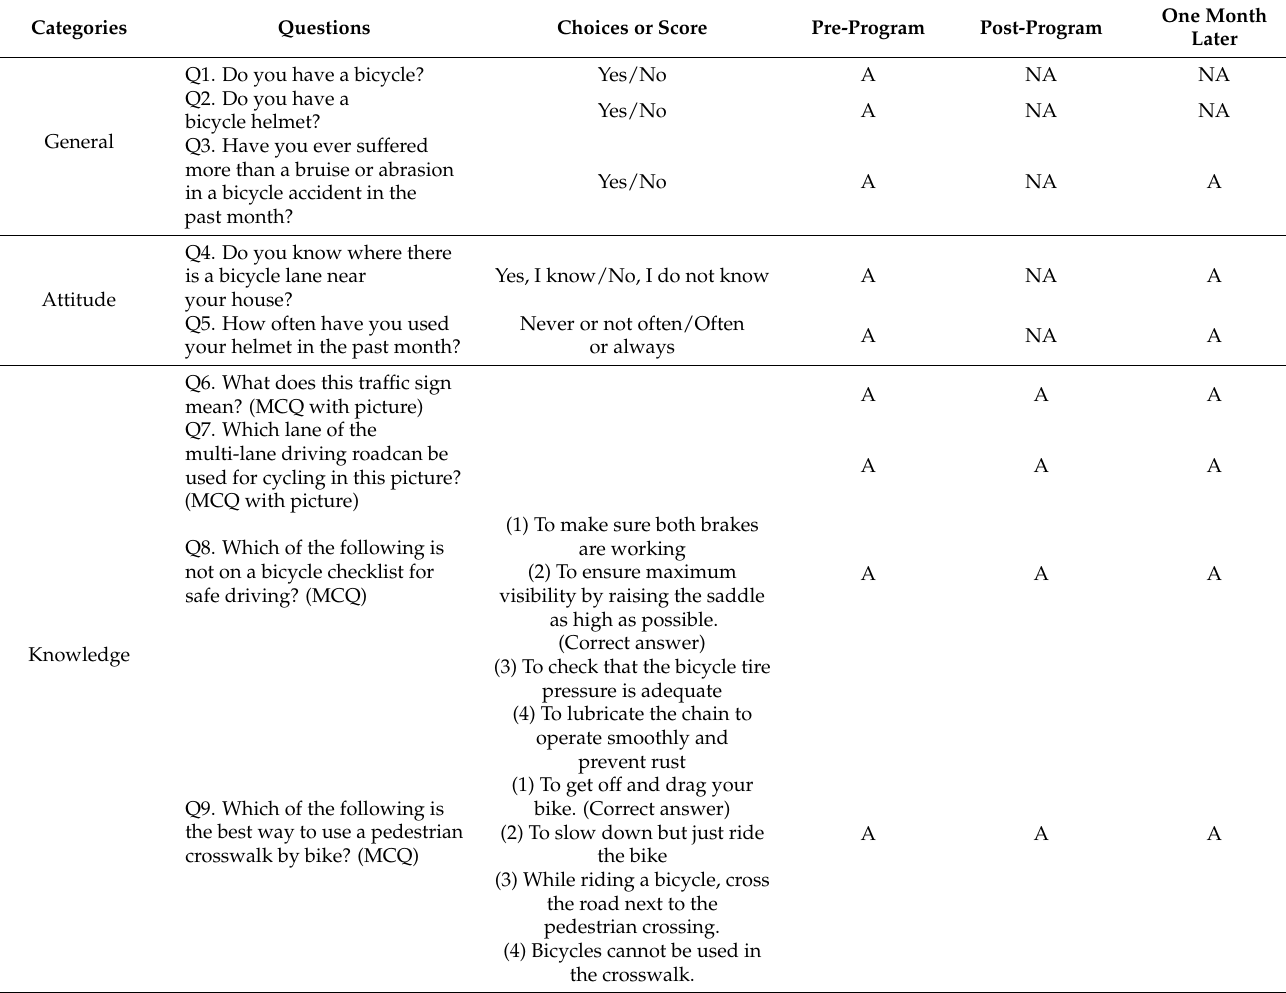
Table 1. Questions on the assessments: Before the program, immediately after the program, and one month